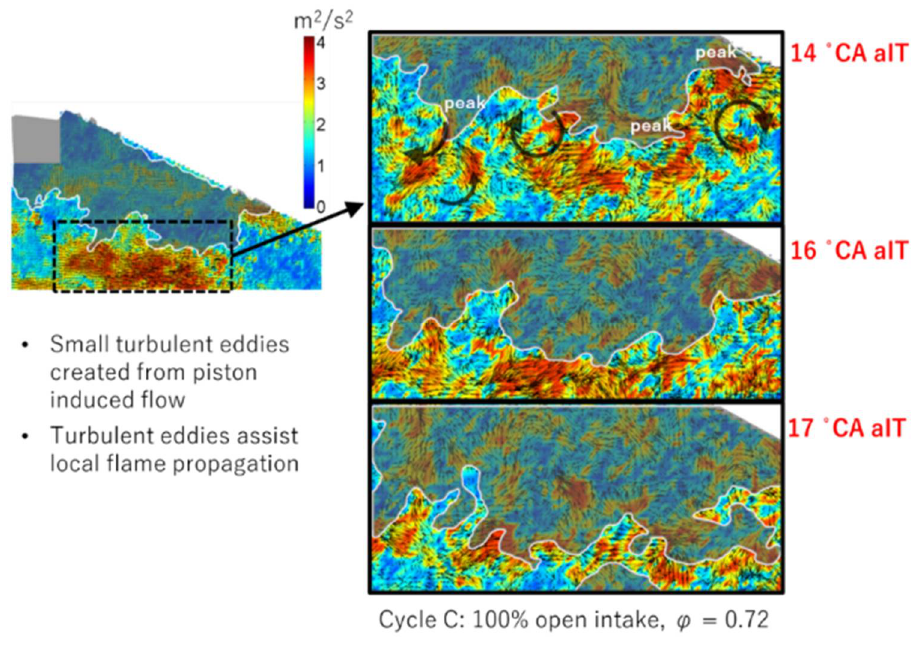
Figure 15. Flow in the cylinder, turbulence, and flame surface in another cycle.